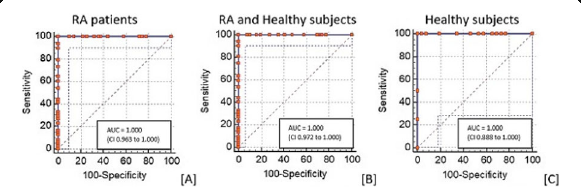
Fig. 1 (abstract P180). Receiver Operating Characteristic (ROC) curve for BDI-II to diagnosis depression in RA (Rheumatoid Arthritis) patients and healthy controls. Patients with RA [A]; patients with RA and Healthy subjects [B]; Healthy subjects